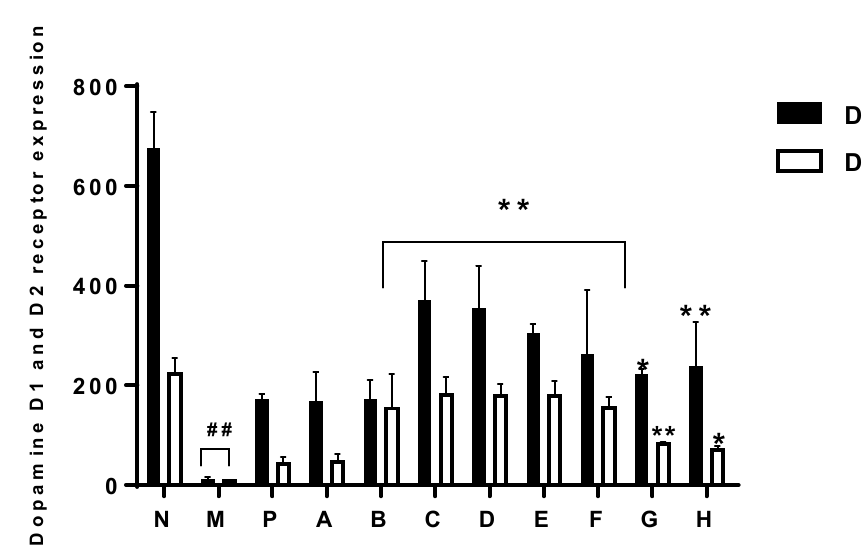
FIGURE 7 – The effects of decoction of different buds of malt on the expression of dopamine D1, D2 receptor in the hypothalamus gland of HPRL rat model. Rat model of HPRL was produced by back subcutaneous repeated injection with 75 mg/kg MCP, for 10 days, followed by treatment with or without 9.46 g/kg decoction of different buds of malt (A to H) or 0.4 mg/kg BMT (P) for 30 days. 0.9% salt solution treated rats were served as model group (M). Normal group were non-modeling and treated (N). At the completion of experimental treatment, tissues of hypothalamus gland of rats in each group were collected respectively. The expression of dopamine D1, D2 receptor was determined by immunohistochemistry. Data are expressed as mean ± SEM (n =